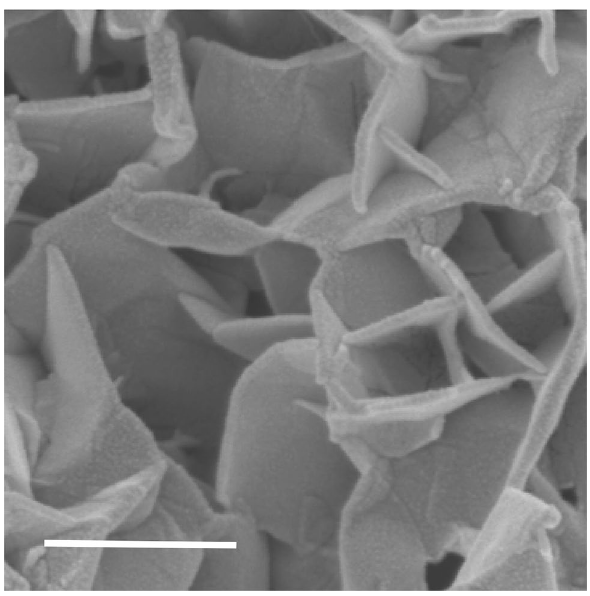
Figure 1. Aggregated hydrotalcite (HTC) platelets formed in situ from a U mine barren lixiviant. Scale bar is 500